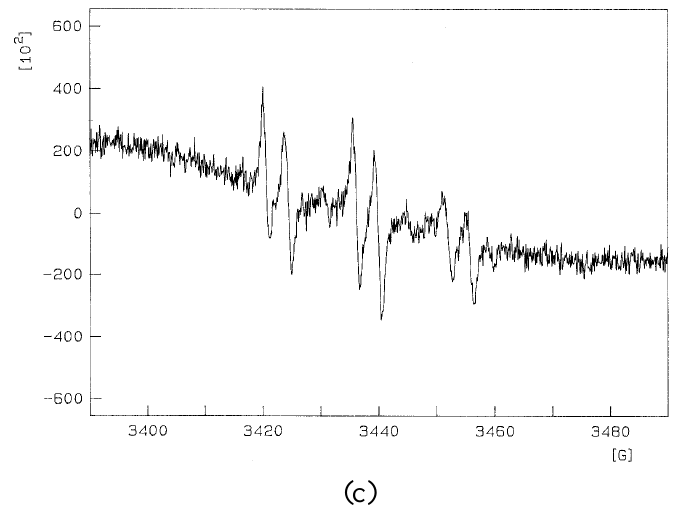
Figure 3. The effect of different concentrations of n -butanol, ethyl acetate, water, chloroform and petroleum ether extracts of Satureja montana L. subsp . kitaibelii on hydroxyl